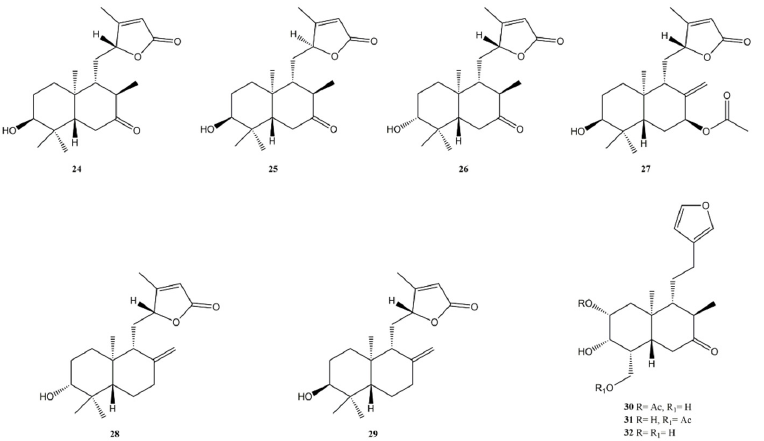
Grazielabdane C ( 31 ); Grazielabdane A ( 32 Figure 5. Bioactive ent-labdane diterpenes: Uasdlabdanes A-F ( 24 – 29 ); Grazielabdane B ( 30 ); Gra- zielabdane C ( 31 ); Grazielabdane A ( 32 ).